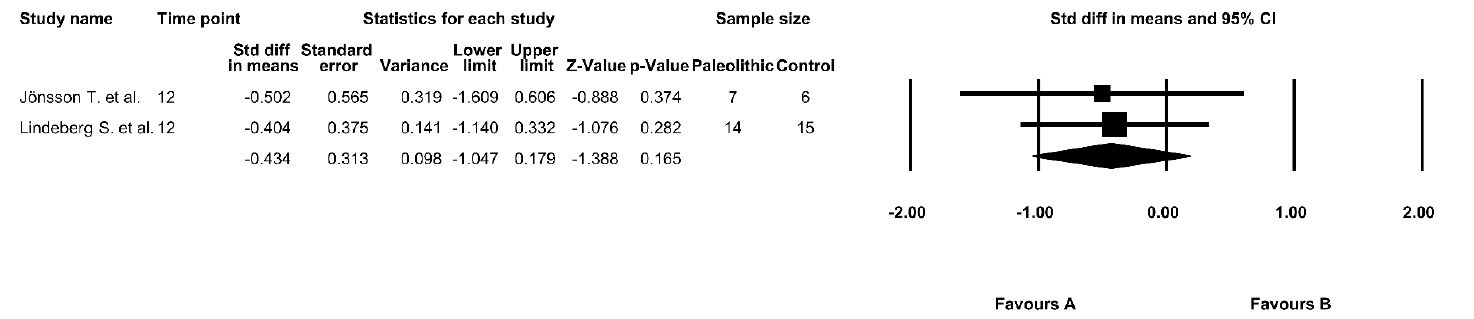
Figure 6. Forest plot comparing HbA1c values between the diets in studies with an intervention period of at least 12 weeks (favors A—Paleo group; favors B—control group).